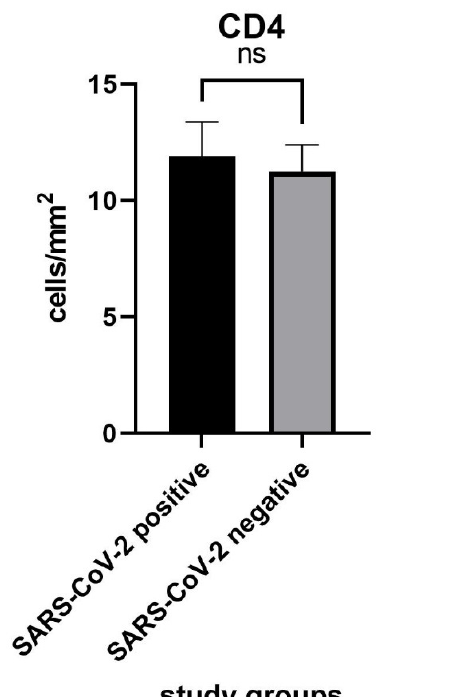
Figure 1. Immunostaining for S1 spike protein of SARS-CoV-2. Note the positivity at the level of eccrine sweat glands (Immunohistochemistry, Original Magnification: 10×).